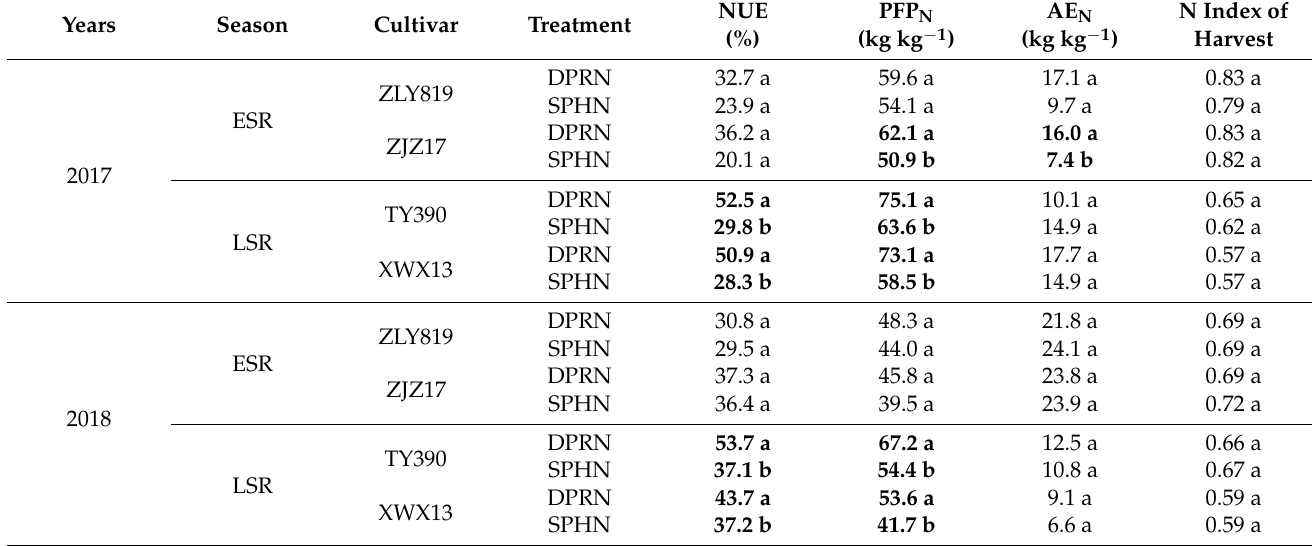
Table 2. Nitrogen-use efficiency of double-cropped rice under different treatments from 2017 to 2019.